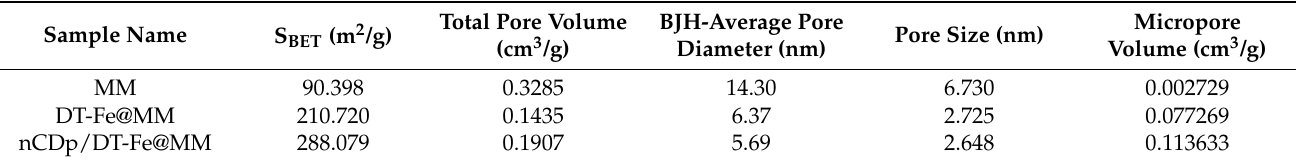
Table 1. Summary of textural properties of the adsorbents from BET